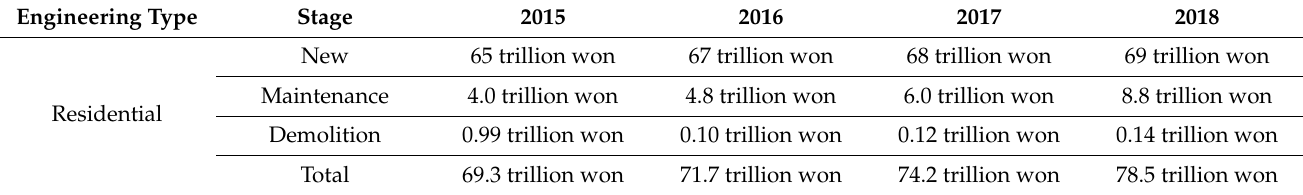
Table 8. Forecasting results of the scale forecasting model in construction